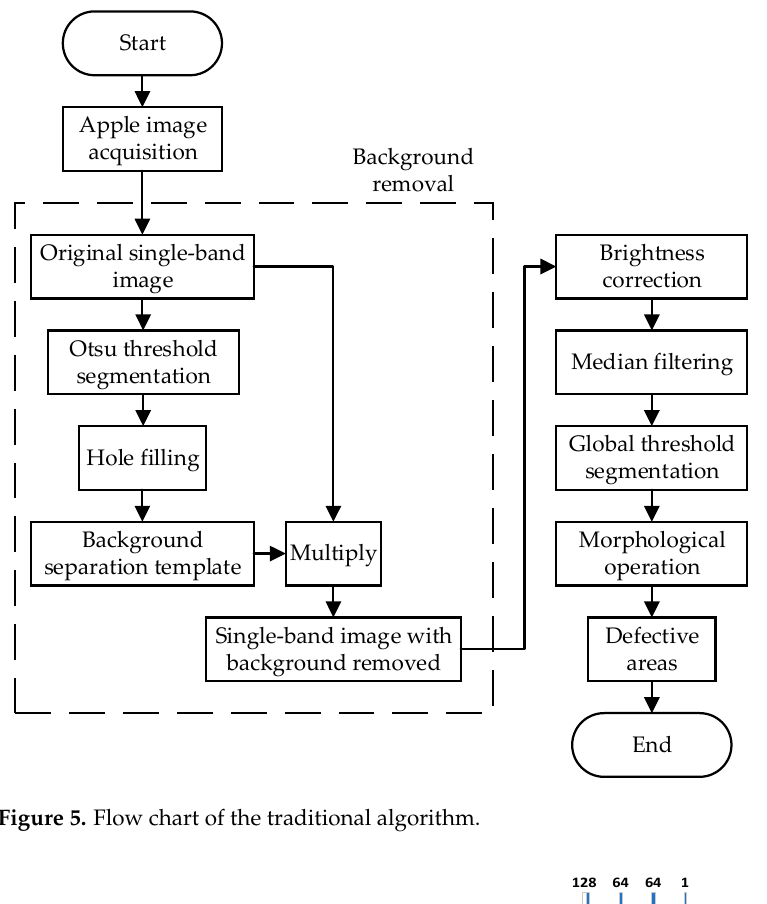
Figure 5. Flow chart of the traditional algorithm.